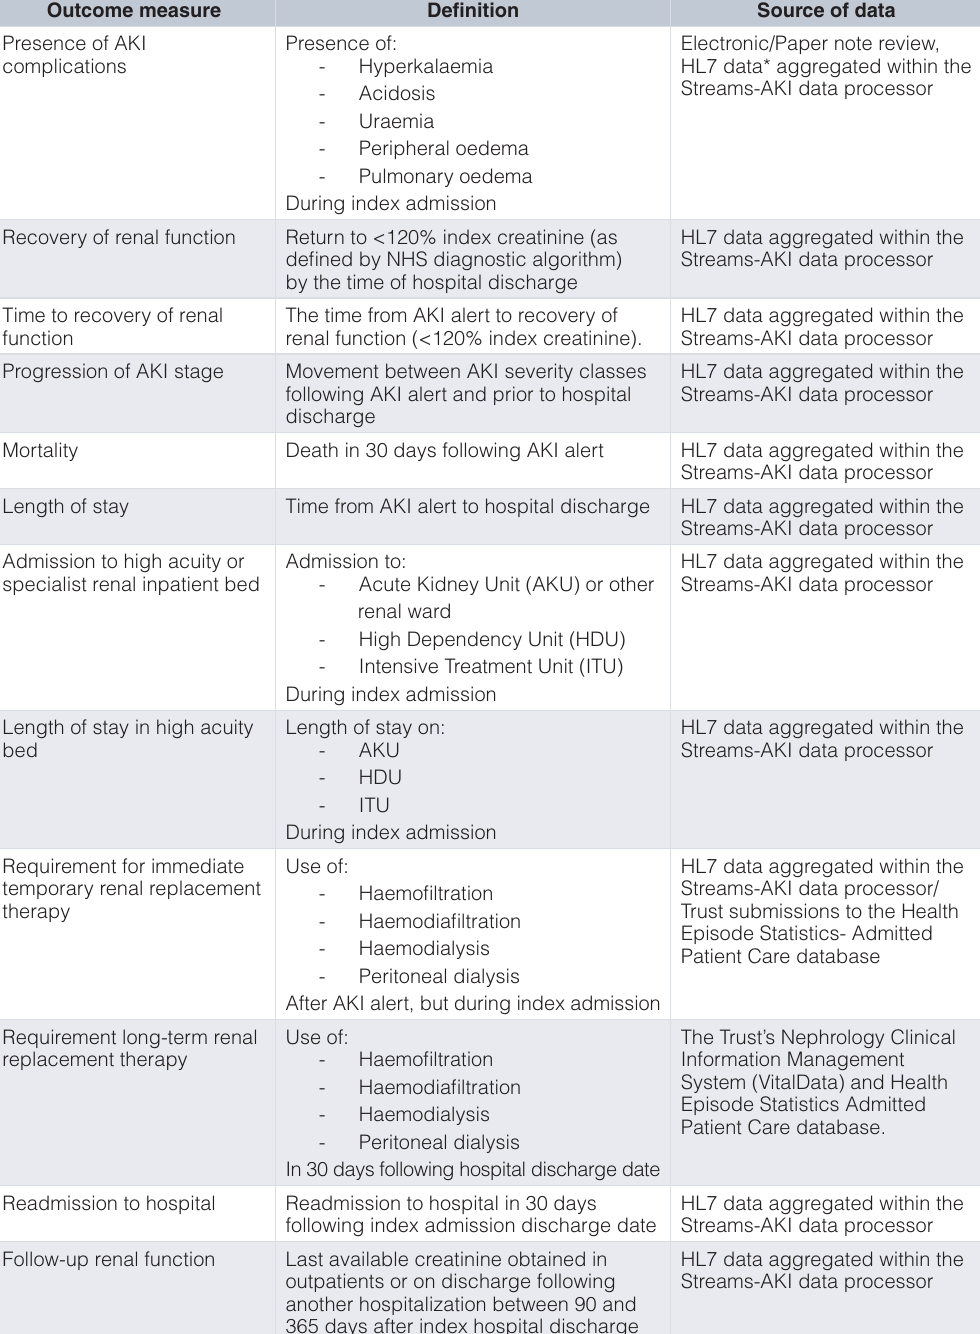
Table 2. Definitions and data sources for all clinical outcome measures. Health Level 7 (HL7) messages are used to transfer information between different healthcare IT